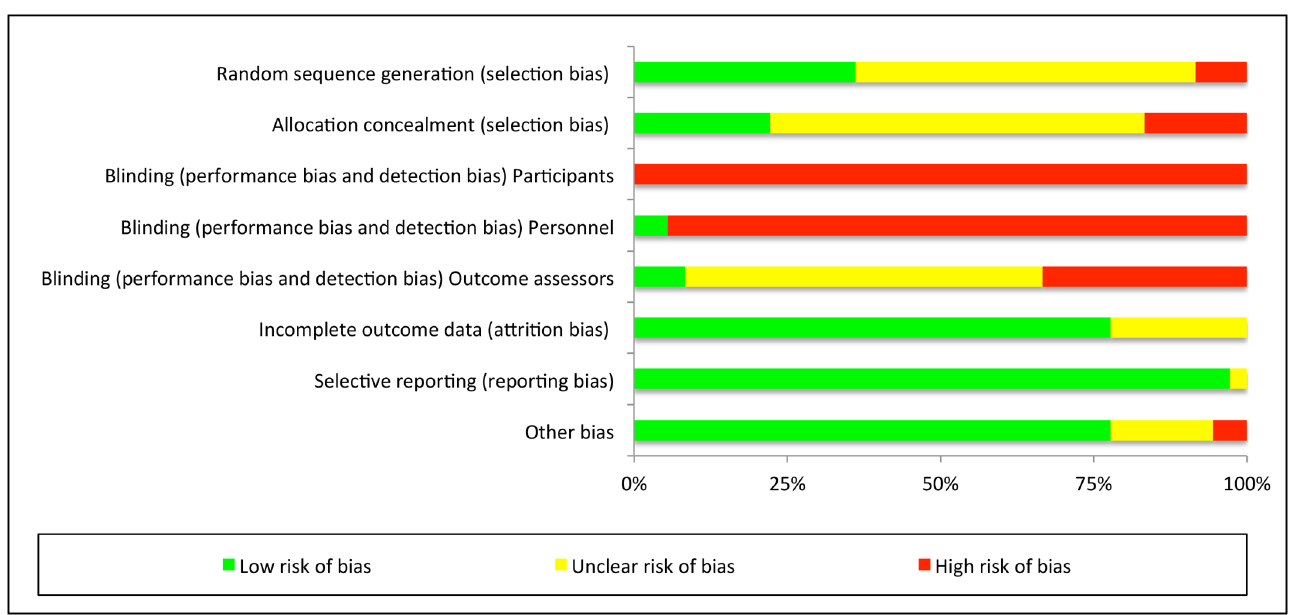
Fig 3. Risk of bias summary for all included